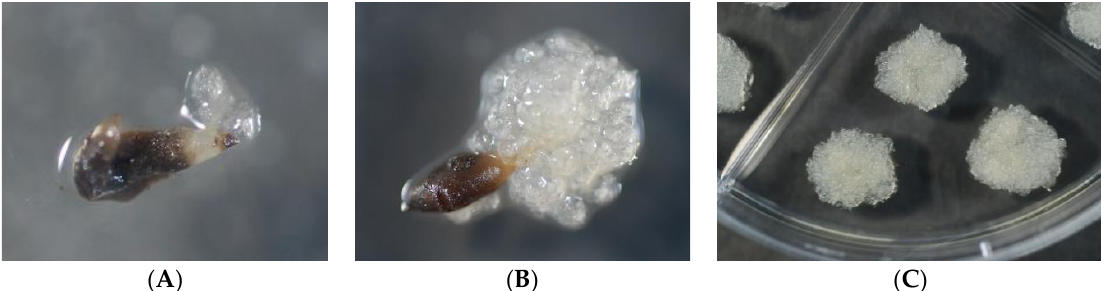
Figure 1. SE initiation in sugi (Japanese cedar, C. japonica ). ( A ) Extrusion of ECs from megagametophyte explant 2 weeks after the start of culture; ( B ) proliferation from extruded ECs after 6 weeks of culture; ( C ) maintenance/proliferation of ECs by 2 – 3-week interval subculture routines. Bars: 5 mm ( A , B ), 1 cm ( C ).